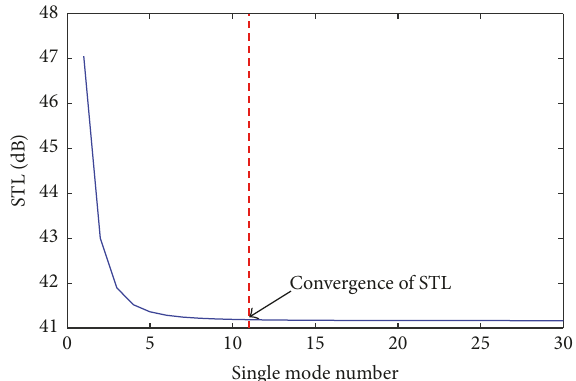
Figure 8: Convergence check of the infinite orthogonally rib- stiffened sandwich structure at the highest frequency of